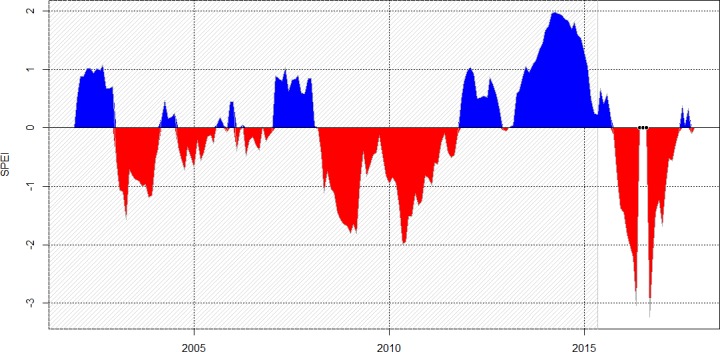
Standardized precipitation-evapotranspiration index on 12-months base.SPEI is expressed in units of standard deviation from the long-term mean of the standardized distribution. Negative values in red represent drought events. The reference period is the dashed area before ENSO.